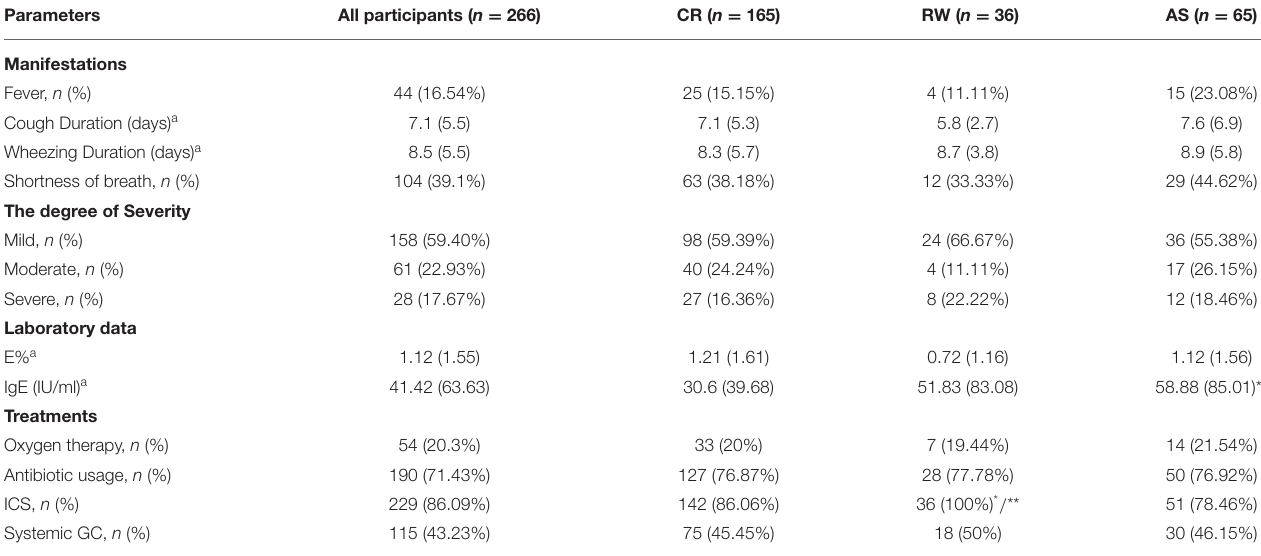
TABLE 2 | Clinical characteristics of patients with RSV bronchiolitis among three groups.